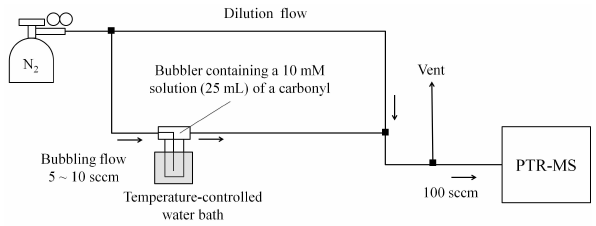
Fig. 2. Experimental setup for the PTR-MS